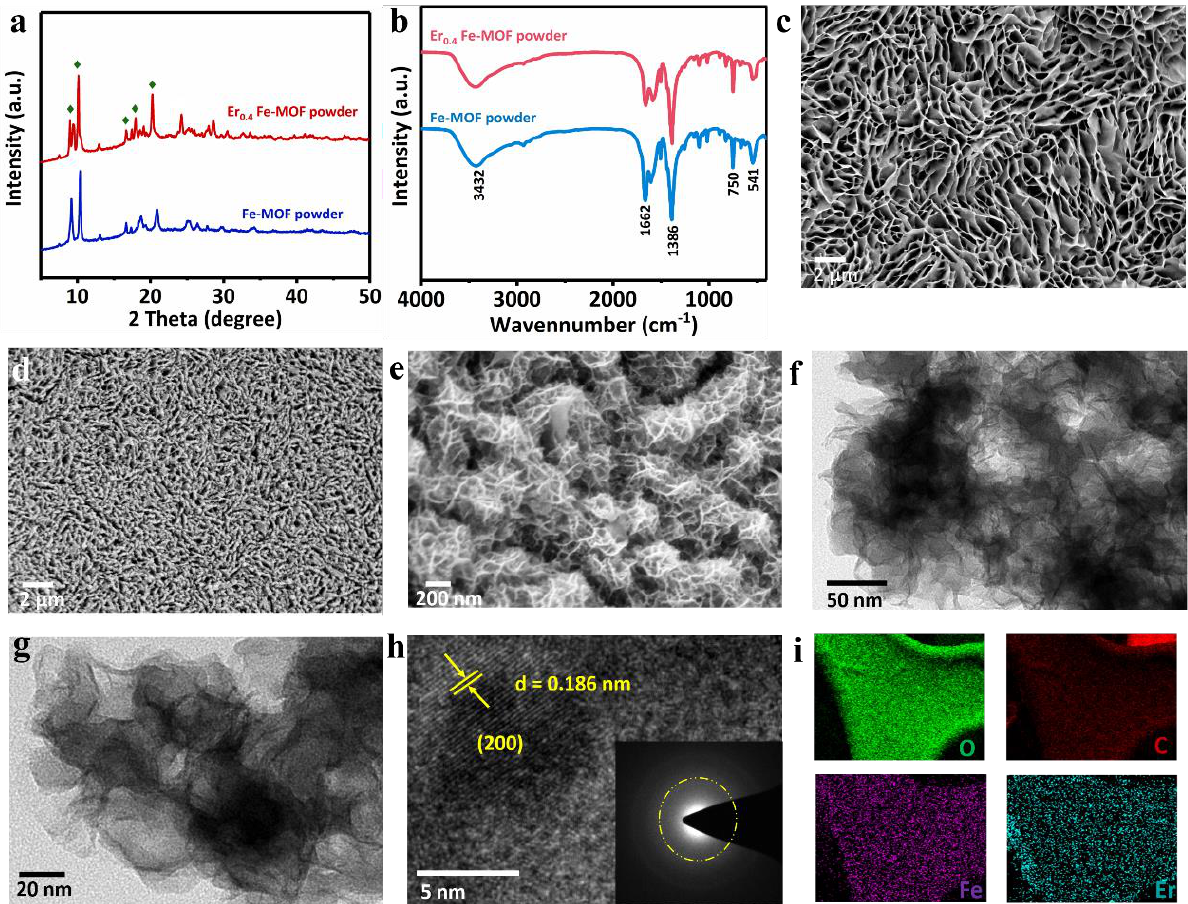
Figure 1. XRD patterns ( a ) and FTIR spectra ( b ) of Fe - MOF/NF and Er 0 . 4 Fe - MOF/NF. SEM image of Fe - MOF/NF ( c ). SEM images ( d , e ), TEM images ( f , g ), HRTEM image ( h ) (inset was the corresponding SAED pattern), and element mapping ( i ) of Er 0 . 4 Fe - MOF/NF.